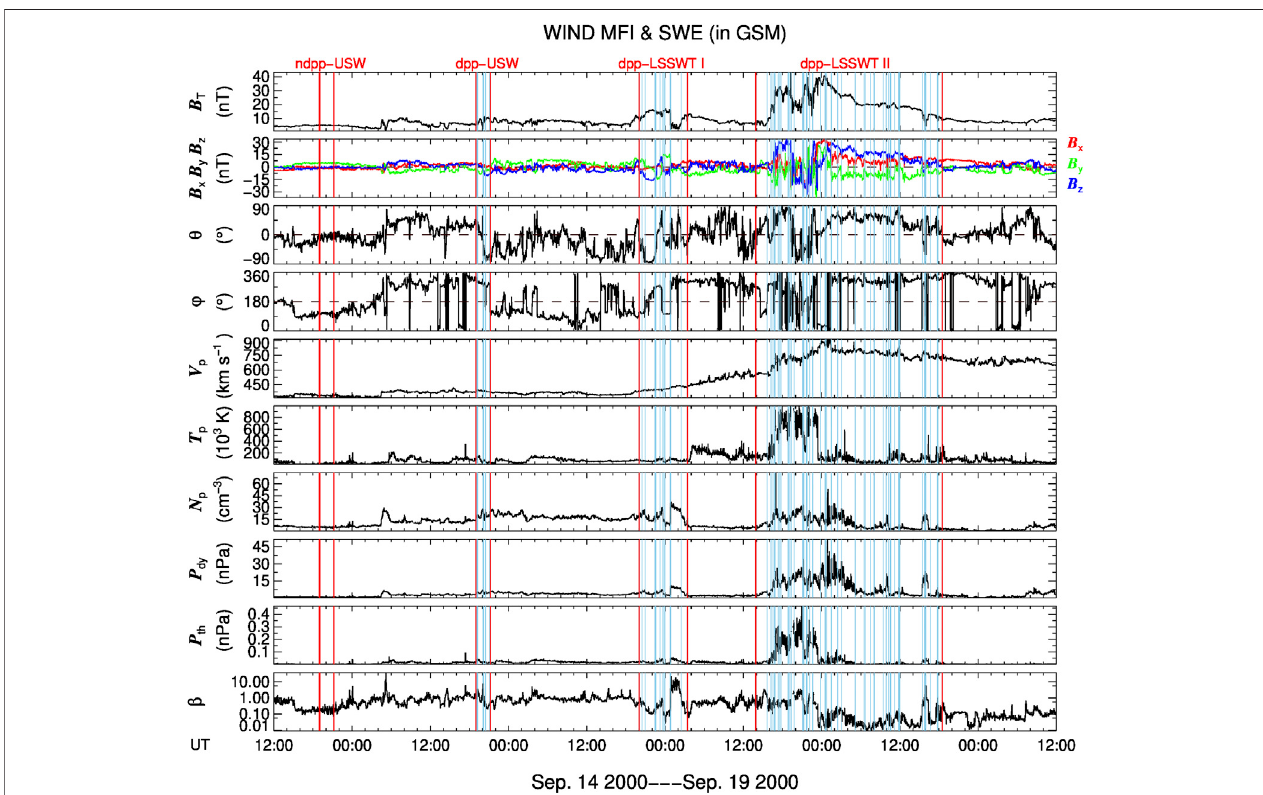
FIGURE4| Magnetic fi eldand plasmaparameters ofsolarwindobservedbyWIND from12:00UTon September 14,2000to12:00UTSeptember 19, 2000.The panels from top to bottom are: magnetic- fi eld magnitude, the three components (x, y, z) of the magnetic fi eld in Geocentric Solar Magnetospheric (GSM) coordinates, magnetic- fi eld latitude angle, magnetic- fi eld azimuthal angle, proton bulk speed, proton temperature, proton density, solar wind dynamic pressure, proton thermal pressure, and plasma beta, respectively. The solar wind dynamic pressure, the thermal pressure and plasma beta are calculated as the functions, P dy (cid:1) m p N p V 2 p , P th (cid:1) N p KT p ,and β (cid:1) P th /( B 2 /2 μ 0 ),respectively.Thefourdiscussedregions,ndpp-USWregion,dpp-USWregion,dpp-LSSWTIregionanddpp-LSSWTII,arelabeledby the red vertical lines, respectively. The center of the transition regions of the captured DPP events are marked by sky blue vertical lines